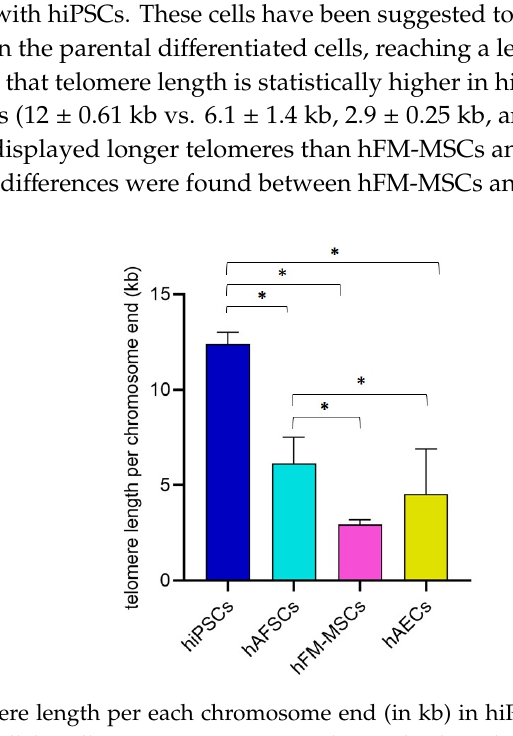
Figure 5. The detection of miR ‐ 299 ‐ 3p, miR ‐ 150 ‐ 5p, and miR ‐ 145 ‐ 5p in hiPSCs and perinatal SCs and their relationship with the protein expression of NANOG, OCT4, and SOX2. The graph shows the ( a ) miR ‐ 145 ‐ 5p expression, ( b ) miR ‐ 150 ‐ 5p, and ( c ) miR ‐ 299 ‐ 3p (primary y axis) and the expression of the NANOG, OCT4, and SOX2 proteins, as measured with the mean fluorescence intensity by the immunocytometry analysis (secondary y axis) in SCs from different fetal annexes. The miRNAs were detected by real time PCR, the fold change was determined from the −ΔΔ Ct values, calculated using U6 as reference gene and normalized to hiPSCs, as the control condition. The graphs show the mean ± SD of 5 independent experiments, p < 0.05 with hiPSCs (*), hAFSCs (#), and hFM ‐ MSCs (§).